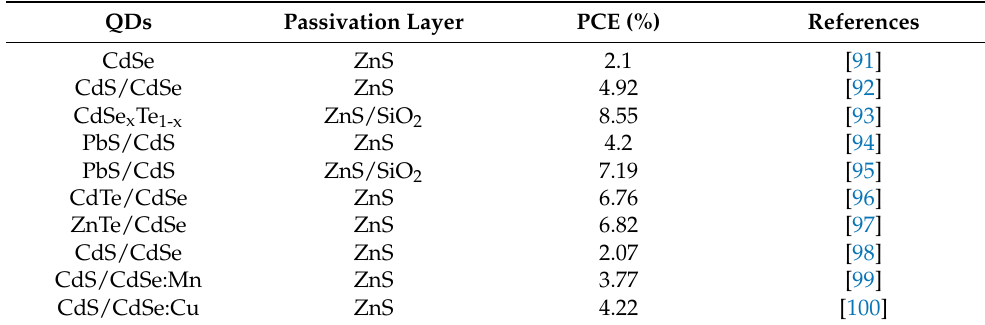
Table 3. Review on QDSSCs with passive surfactant.